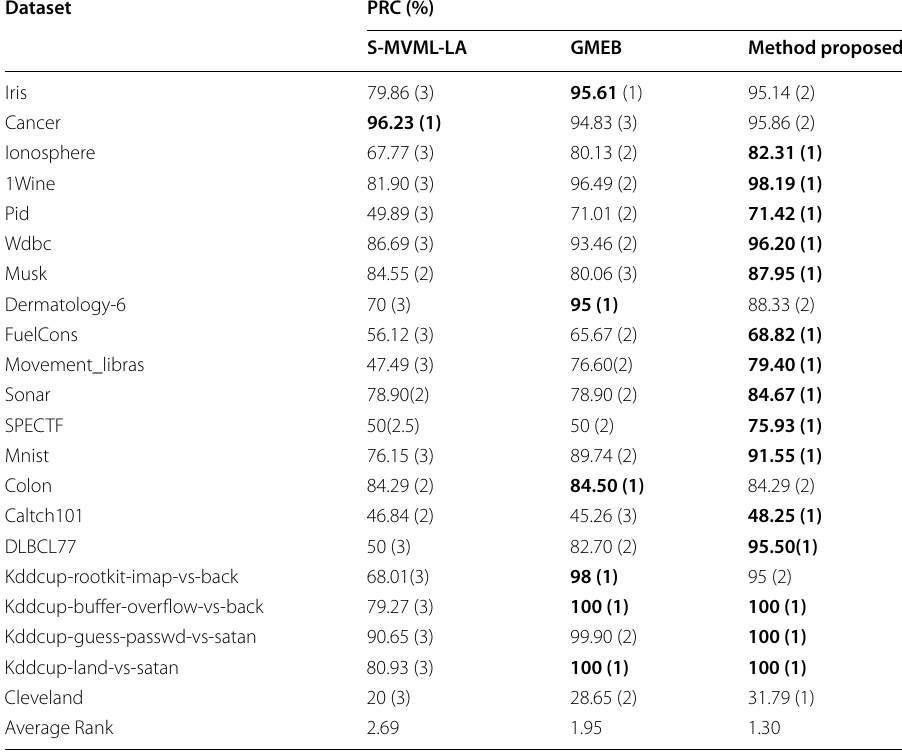
The numbers in bold are the best accuracies achieved on the dataset